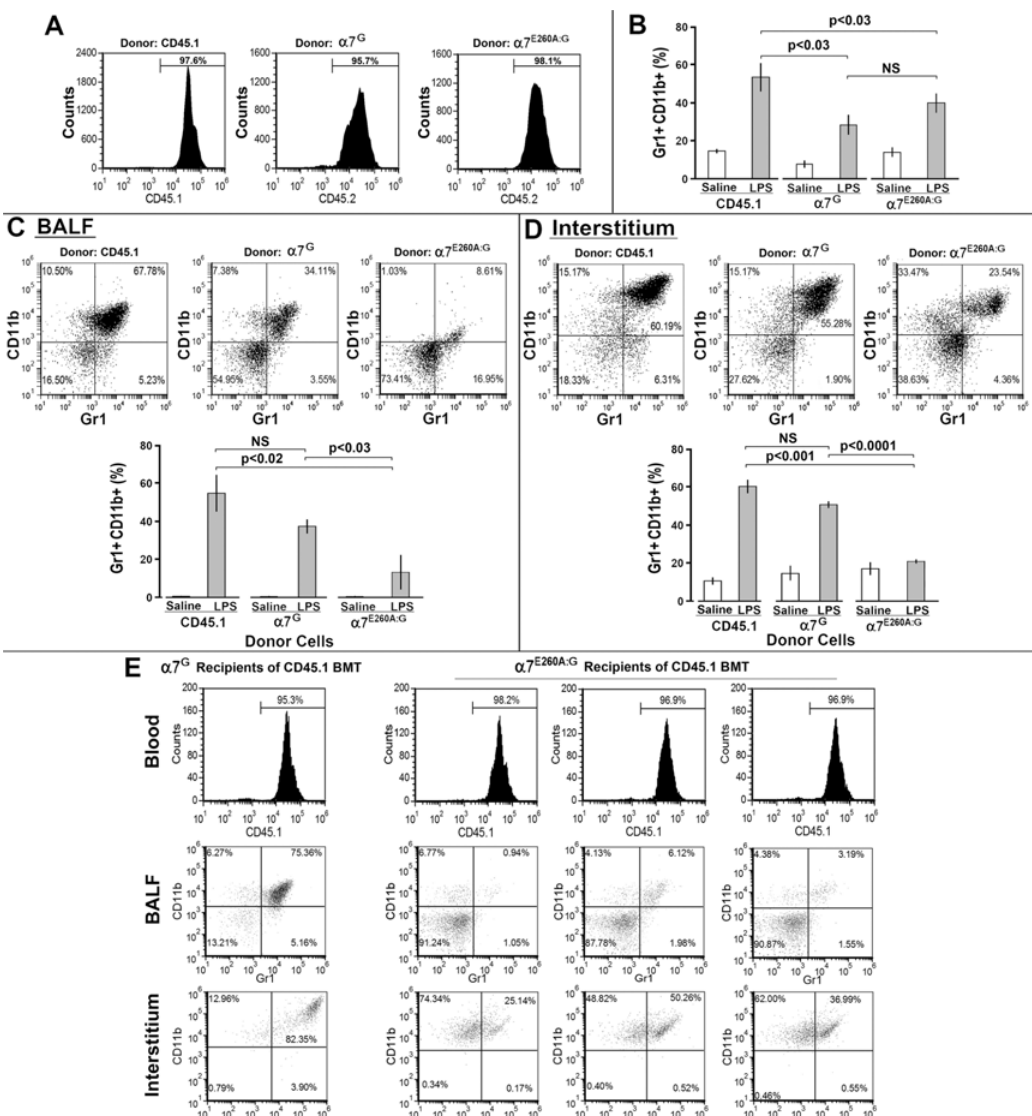
Fig 5. The response of chimeric α 7 G / α 7 E260A:G mice to i.n. LPS. (A) Bone marrow cells were isolated from either B6.SJL (CD45.1 allele), α 7 G (CD45.2 allele), or α 7 E260A:G (CD45.2 allele) mice. B6.SJL (CD45.1 allele) mice were lethally irradiated with a dose of 2 x 6Gy, and 5 x 10 6 cells per mouse were injected retro-orbitally into these recipients. Blood samples at 12 weeks post reconstitution show that greater than 95% of the nucleated cells of the blood were of donor origin. (B) Thirteen weeks post-BMT mice were challenged with either i.n. saline or i.n. LPS as above and a blood sample was obtained at 24 hrs post-challenge. All engrafted mice responded to LPS as measured by an increase in Gr1 + CD11b + cells in the blood. (C) BALF was obtained at 72 hrs post LPS challenge by lavage of individual mice and stained for Gr1 + CD11b + . The total number of cells isolated from the BALF of the recipient mice repopulated with CD45.1 donor BM challenged with LPS was 2.4 x 10 6 cells and 2.1 x 10 6 cells from recipients repopulated with the α 7 G donor BM, while the recipients of the α 7 E260A:G BM had only 0.7 x 10 6 BALF cells following LPS challenge. Similarly, the number of CD45 + cells recruited to the interstitium of the CD45.1 and α 7 G mice was equivalent while the number of CD45.1 BM cells recruited to the interstitium of the α 7 E260A:G mice was reduced. The bar graphs represent the average response of the mice to LPS and significance calculated using the Student ’ s t-test. (D) Following removal of BALF, interstitial tissue cells were isolated and stained for flow cytometry. Bar graphs reflect the average population response as indicated. (E) Bone marrow cells were isolated from B6.SJL (CD45.1 allele) mice and injected into lethally irradiated α 7 G or α 7 E260A+/+:G mice (CD45.2 allele). At 12 weeks recipient mice were fully reconstituted with CD45.1 cells (Blood, top panel). At week 13, recipient mice were challenged with either i.n. saline or LPS and sacrificed at 72 hrs for isolation of BALF or interstitium. A representative response in the BALF and interstitium (gated on CD45.1 cells) of the α 7 G cellular response (CD45.1 donor cells transplanted into α 7 G recipient mice) is shown in the left column. The total number of BALF cells from α 7 G recipients of CD45.1 BM averaged 1.8 x 10 6 cells/mouse following LPS challenge while the BALF of α 7 E260A:G recipients of CD45.1 cells contained significantly less (0.5 x 10 6 cells/mouse). CD45 + interstitial cell numbers also reflected this difference in total number of recruited cells with significantly fewer CD45.1 cells recruited to the lungs of the α 7 E260A:G recipients (2.3 x 10 6 versus 1.5 x 10 6 , respectively). The LPS response of the CD45.1 recipients of α 7 E260A:G BM is shown for 3 individual mice (right panels).